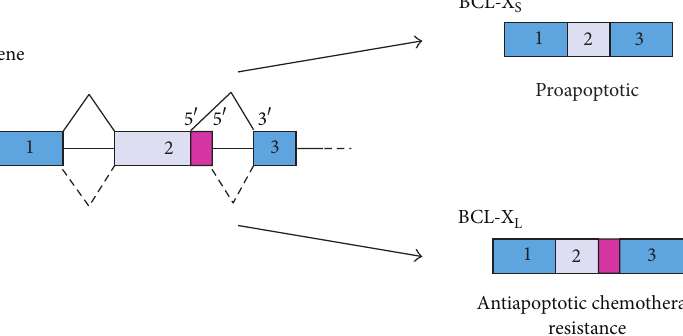
Figure 1: Representative examples of genes whose alternative splicing affects prostate cancer cell biology. The left side of the figure illustrates the genomic structure of the alternatively spliced regions of the AR , CCND1, and BCL-X genes. Solid and dashed lines show the alternative splicing events reported in the literature. On the right side, the alternative variants produced by splicing are shown. The specific features of the protein isoforms produced by alternative splicing are summarized under the scheme of each